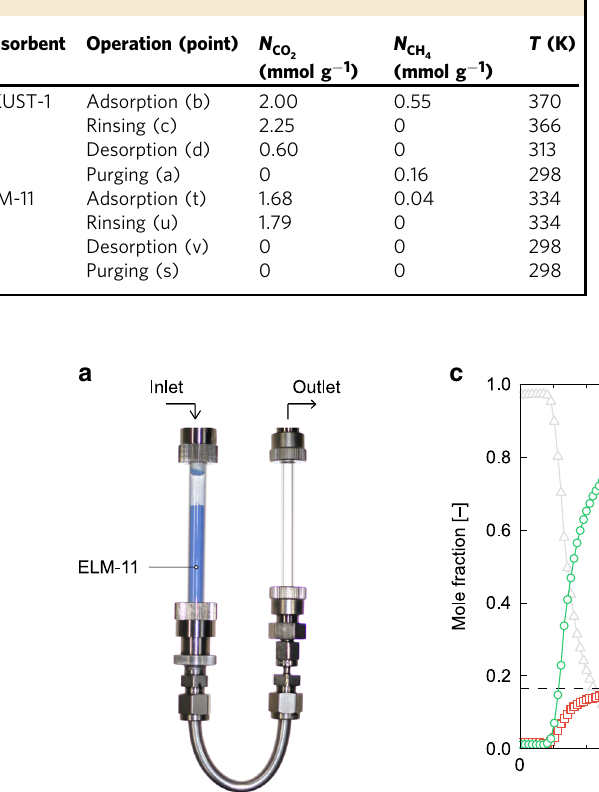
Table 1 Adsorbed amounts of CO 2 and CH 4 and temperatures at points a − d and s − v in Fig. 5a,b.